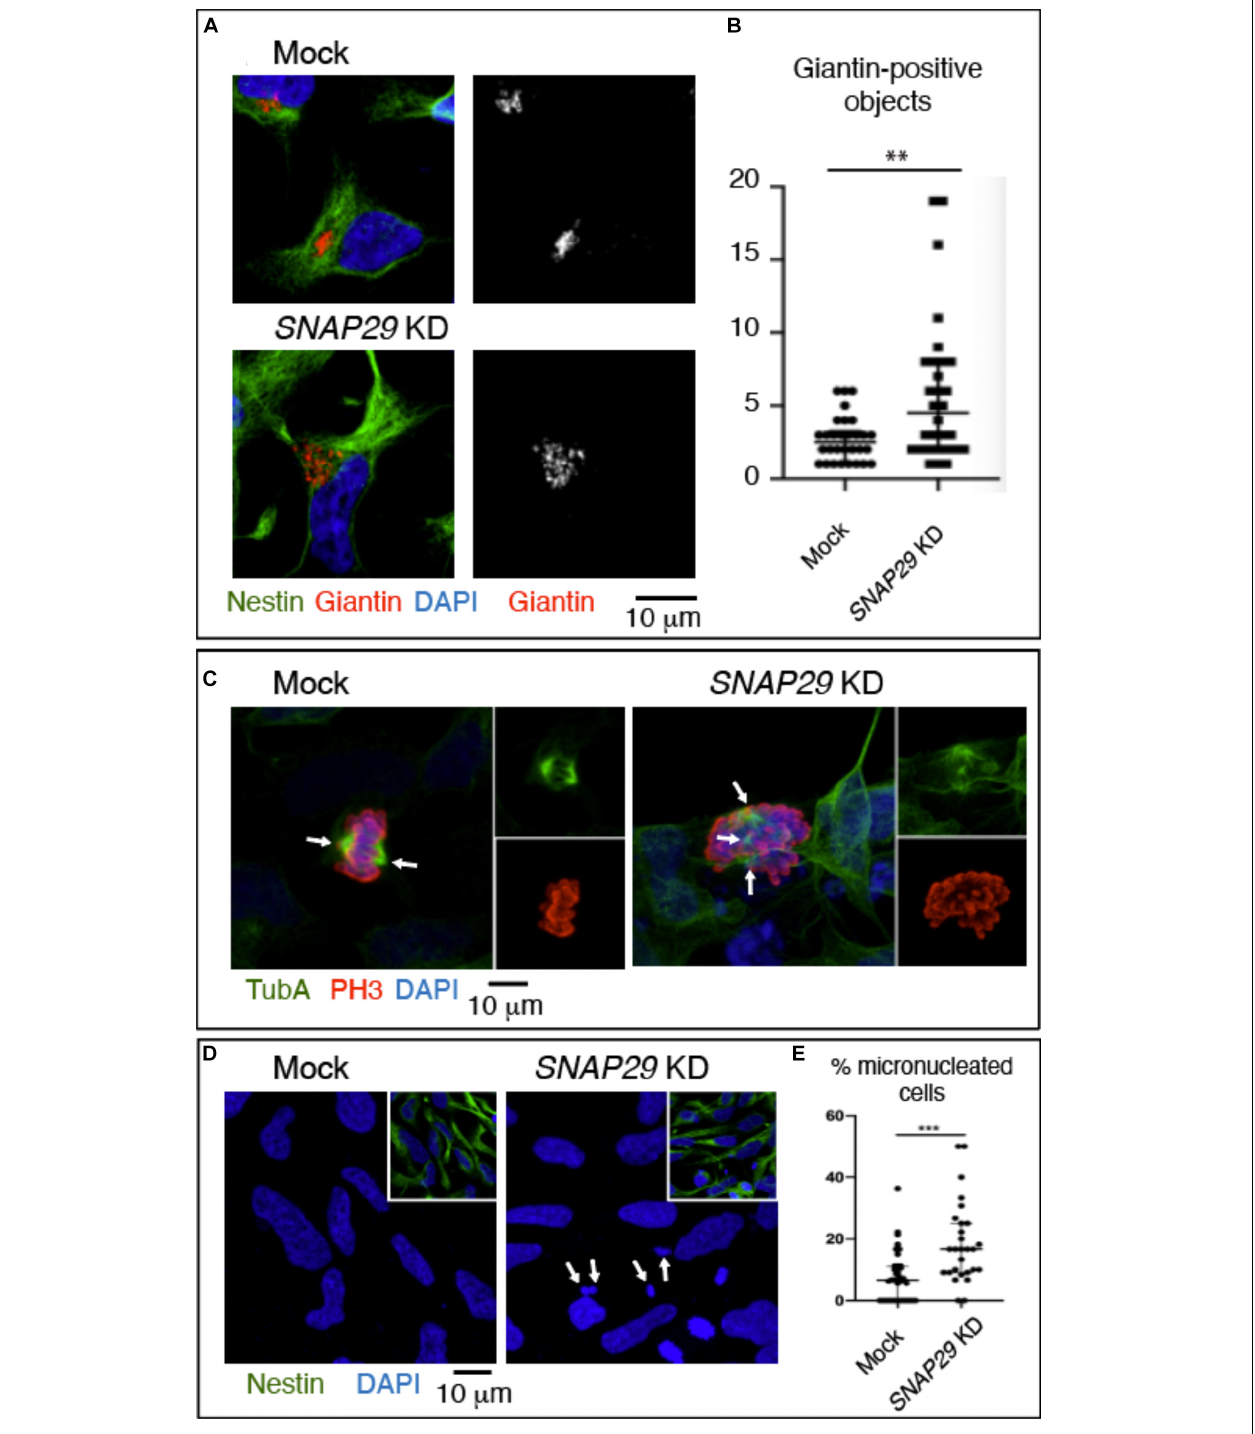
FIGURE 6 | SNAP29 depletion in neuroepithelial stem (NES) cells causes Golgi apparatus (GA) and spindle alteration and formation of micronuclei. (A) Maximal confocal projections of NES cells treated and stained as indicated. Depleted NES cells display GA fragmentation. (B) Quantification of the number of Giantin-positive objects. The median with interquartile range is shown, and the p -value is obtained by Mann–Whitney test. (C) Maximal confocal projections of NES cells treated and stained to detect α -tubulin and p-Histone3. The depleted NES cells in metaphase show an altered mitotic spindle. The arrows indicate spindle poles. (D) Maximal confocal projections of NES cells treated and stained as indicated. The depleted NES cells possess several micronuclei (arrows). (E) Quantification of the percentage of cells with at least one micronucleus. The median with interquartile range is shown, and the p -value is obtained by Mann–Whitney test.